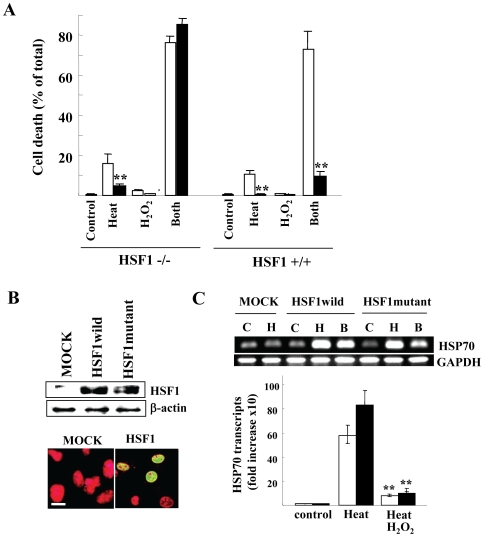
Effect of thermal preconditioning on H2O2-treated HSF +/+ and -/- MEFs.
A) Cell death at 24 h after indicated treatments with (closed) or without (open bars) thermal preconditioning. Both MEFs were treated as indicated, heat (Heat; 42.5°c for 20 min), 0.5 mM H2O2 treatment (H2O2) and both treatments (Both). **, P<0.01 compared with un-preconditioned cells. B) HSF1 overexpression. The indicated HSF1 expression vectors were transfected into HSF1-/- MEFs and cell lysates were harvested at 2 days after transfection. β-actin demonstrates equal loading of protein samples (upper). Nuclear localization of HSF1 in HSF1-rescued MEFs was evaluated by confocal microscopy. The nucleus was counterstained with PI and bar indicates 10 µm. (lower panel). C) HSP70 transcripts were evaluated by RT-PCR transcription in cells 1 h after exposure to heat alone (H; 42.5°c 20 min), heat after 0.5 mM H2O2 pretreatment (B) or untreated cells (C). GAPDH mRNA levels ensure that the RNA was correctly quantified (upper). After indicated treatments, HSP70 transcripts in transfectants expressing wild-type (open) or mutant HSF1 (closed bars) were determined by real-time PCR and normalized to GAPDH levels (lower panel). **, P<0.01 compared with H2O2-untreated cells. In A and C, error bars indicate the mean ± S.D. of data from three separate experiments and